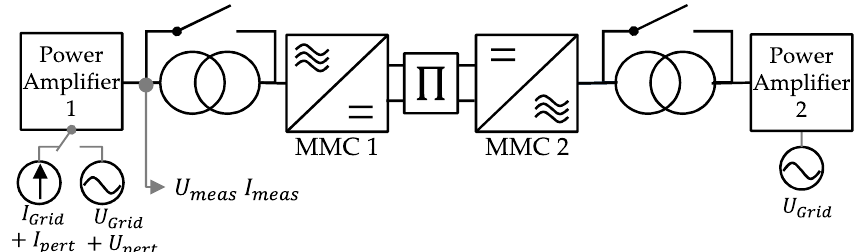
Figure 13. MMC TB setup for the impedance